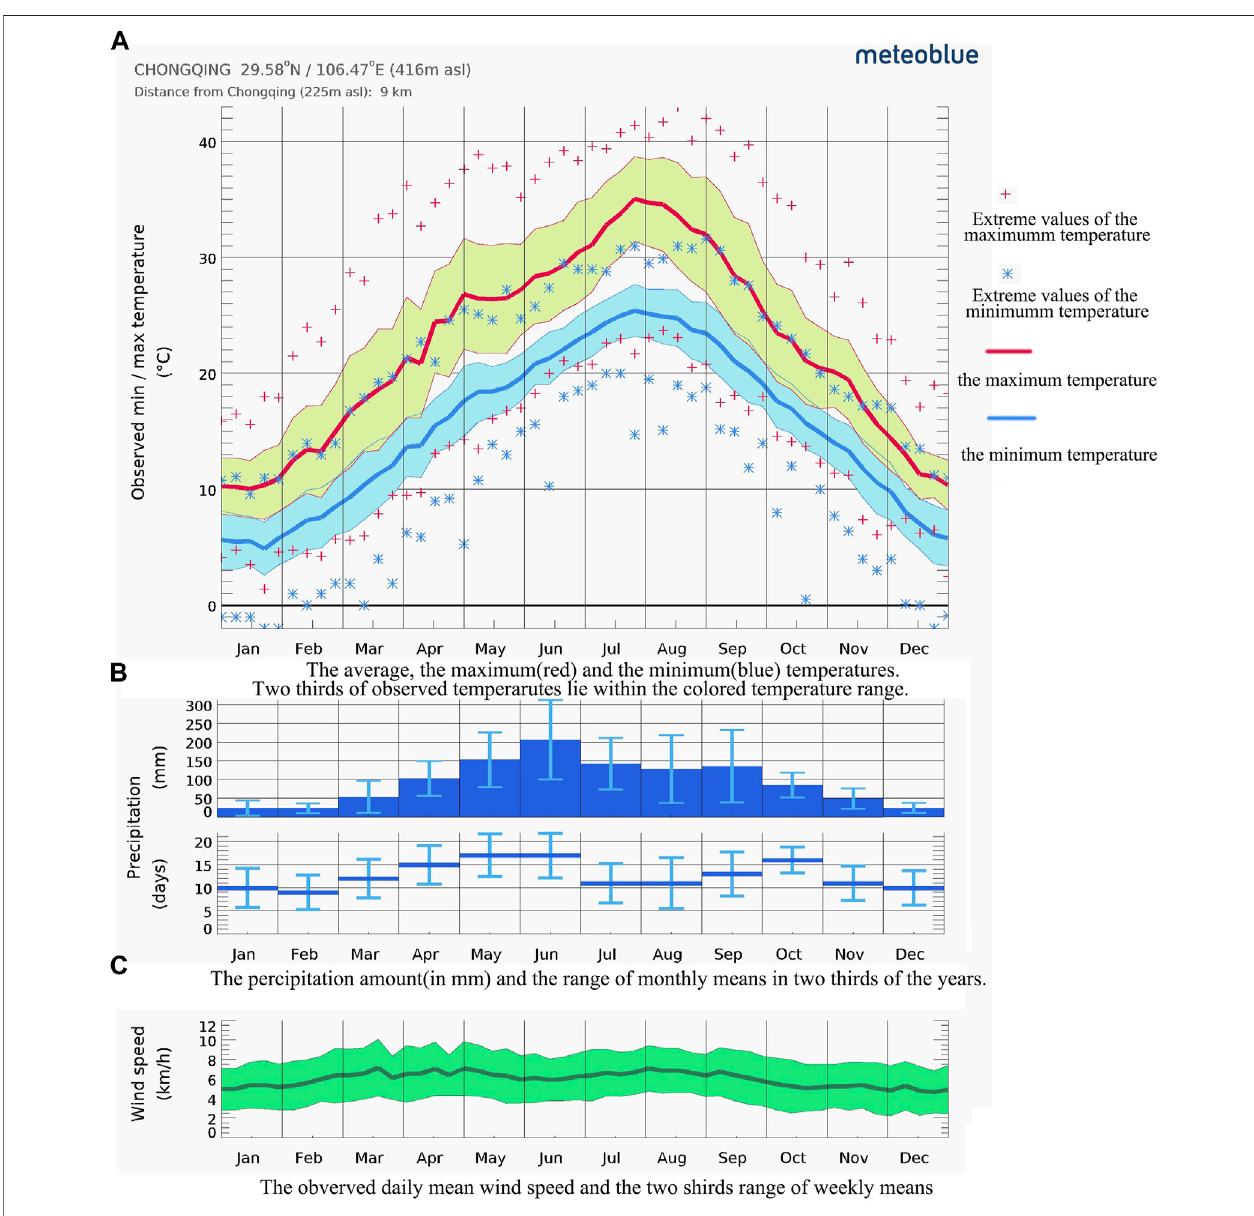
FIGURE 1 | Monthly variations of meteorology-temperature (A) , precipitation (B) and wind speed (C) .